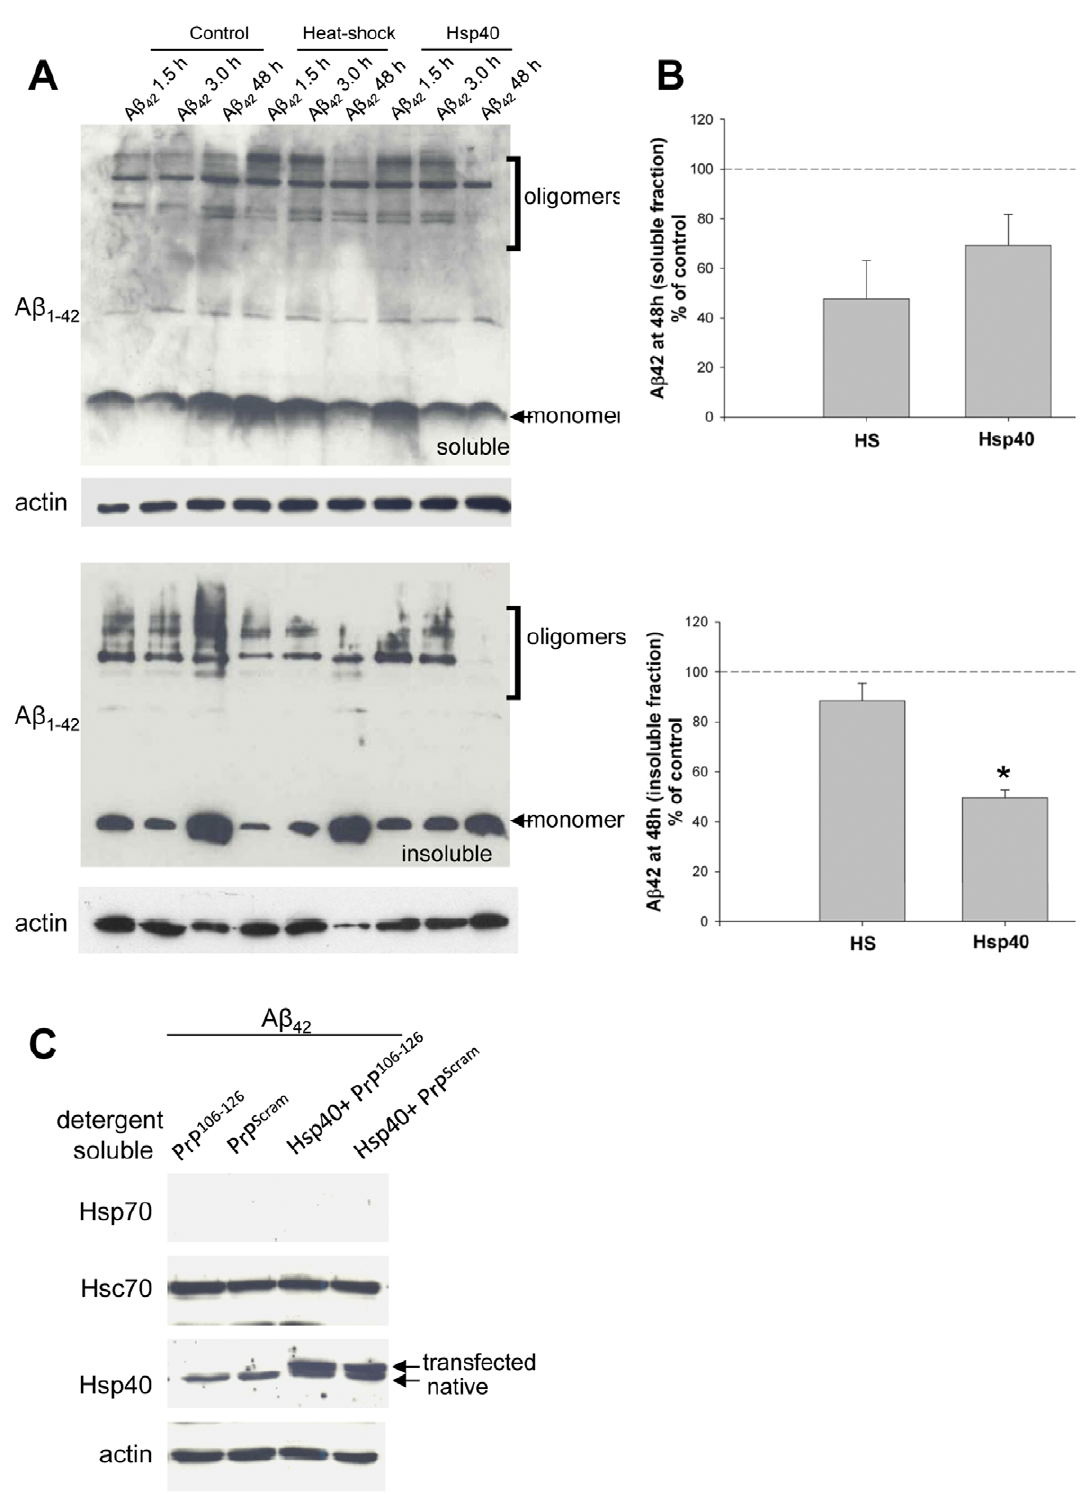
Figure 7. Transient transfection of Hsp40 reduces cellular A b 42 . ( A ) CAD cells were transiently transfected with Hsp40 as indicated for 24 hours prior to the addition of 3 m M A b 42 . Immediately following addition of A b 42 , indicated cells were subjected to heat shock at 43 u C for 40 minutes and allowed to recover. At the indicated times cells were washed in PBS, lysed separated into soluble and insoluble fractions and cellular levels of A b 42 were determined by Western analysis. Actin is shown as a loading control ( B ) Quantification of three independent experiments. *p , 0.05. ( C ) Western analysis of CAD cells transfected with Hsp40 as indicated prior to incubation with 3 m M A b 42 or 0.5 m M PrP 106 2 126 or scrambled control. Data are representative of 4 separate experiments.